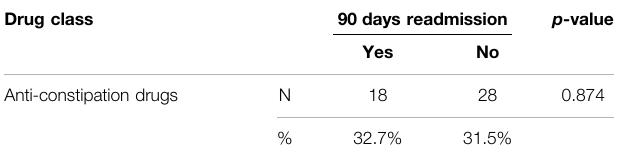
TABLE 9 | Medications among readmission.